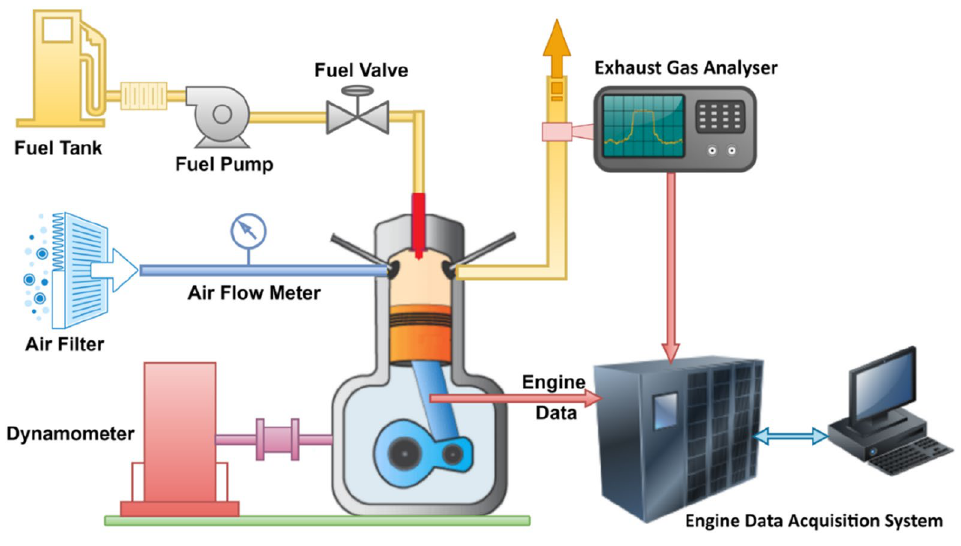
Figure 1. Schematic engine